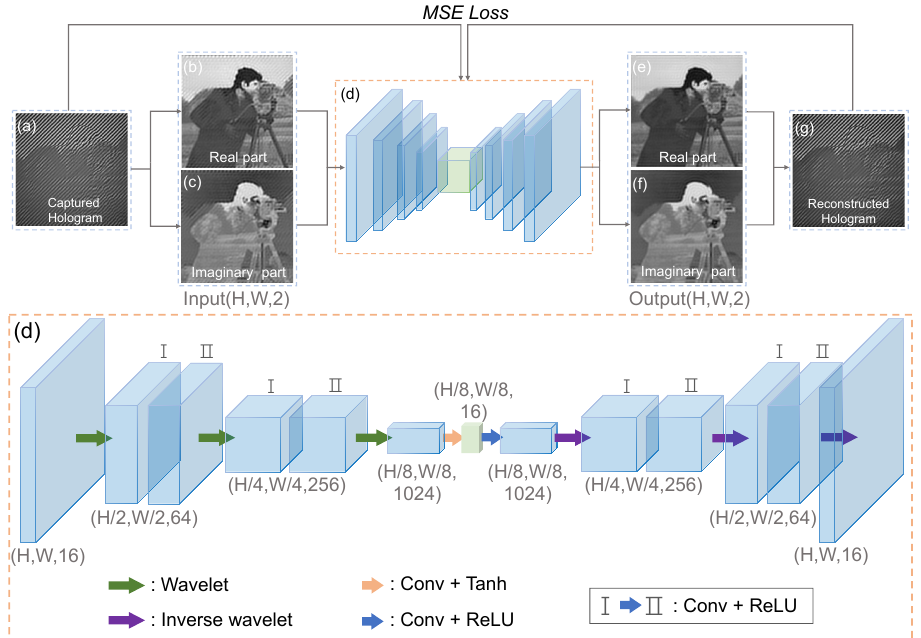
Figure 2. The overall block diagram of the proposed learning approach. ( a ) The captured hologram. ( b , c ) The real and imaginary parts of the complex amplitudes recovered by the FT method as the input of the network. ( d ) The deep convolutional auto-encoding network with “hourglass” architecture. ( e , f ) The corresponding results reconstructed by the network. ( g ) The reconstructed